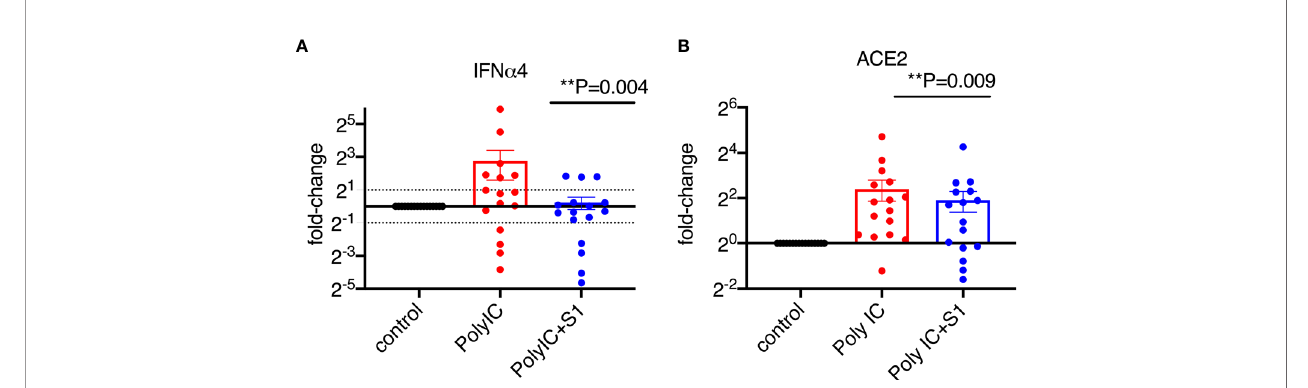
FIGURE 4 | SARS-CoV-2 spike protein reduced poly I:C-induced mRNA expression of ACE2 and type I interferon in lung bronchoalveolar lavage from naïve macaques. Primary lung bronchoalveolar lavage fl uids from 16 naïve rhesus macaques were cultured with 1 m g of poly I:C with or without 1 µg/ml of spike protein S1 for 20 hrs. RNAs were isolated with Trizol and followed by reverse transcription. Macaque-speci fi c primer/probe sets for ACE2 (B) , interferon a 4 (A) was used. Data are shown in mean±SEM. Wilcoxon signed rank tests were used to calculate the p values between the poly I:C-only fold change vs the poly I:C+S1 fold change for interferon and ACE2.